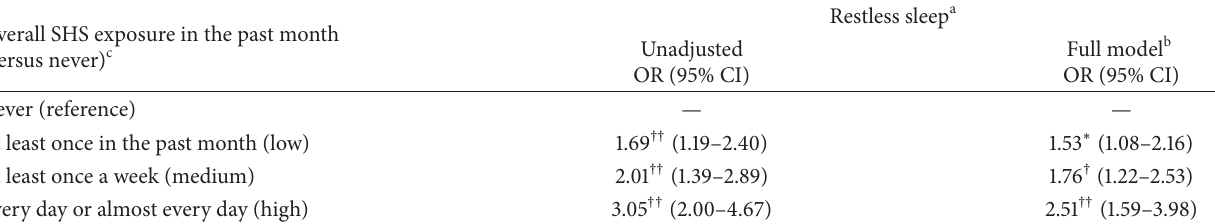
Table 2: Odds ratios (OR) for reporting more frequent restless sleep by frequency of SHS exposure among a sample of adolescents ( 𝑁 = 1 ,466).